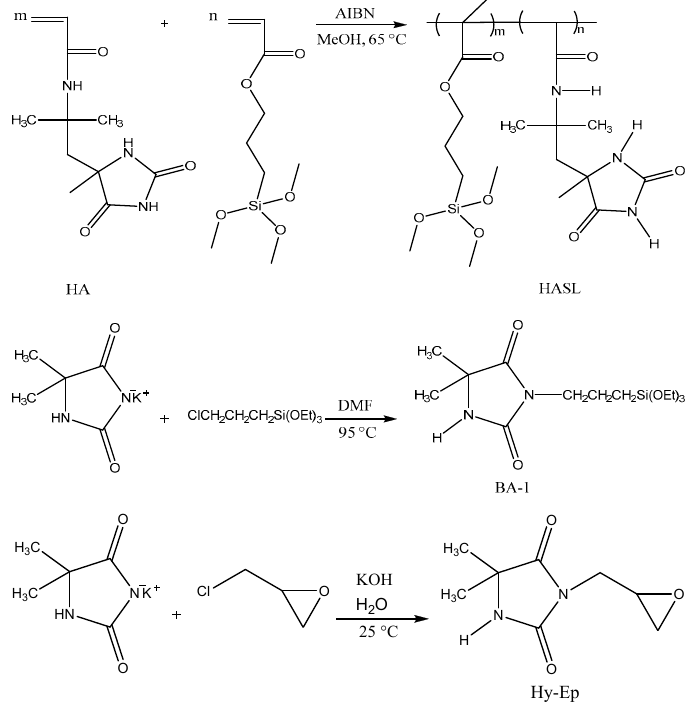
Scheme 2. Schematic synthesis routes of